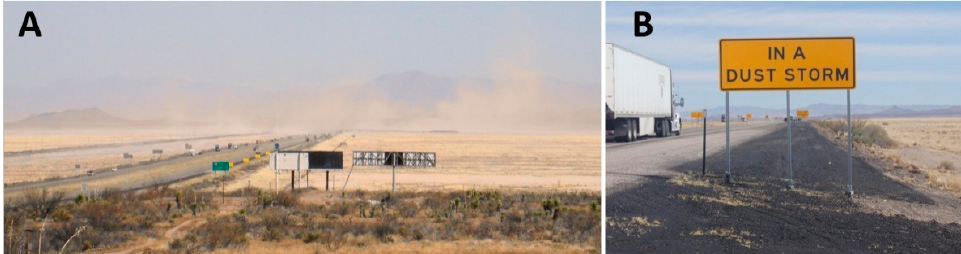
Figure 1. ( A ) I-10 crossing Lordsburg Playa, looking northeastward from west edge of playa, with dust crossing the center of the playa from northwest to southeast. Photo by T.E. Gill. ( B ) Highway signs warning of dust hazard and prescribing safe actions for drivers in reduced visibility as vehicles approach Lordsburg Playa on I-10. Photo by R.S. Van Pelt.